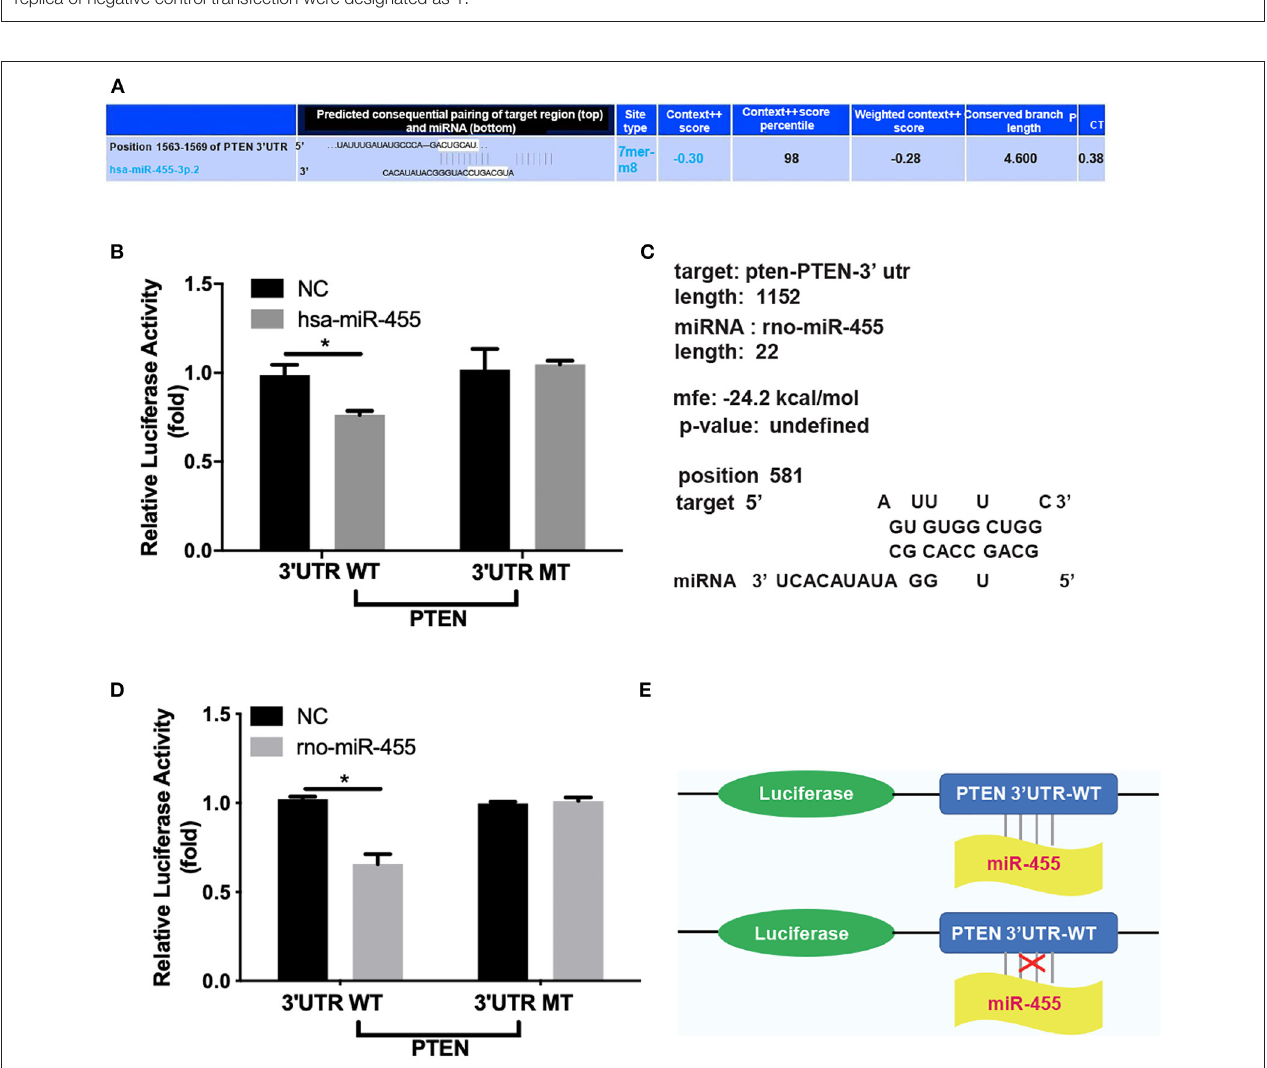
FIGURE 2 | flow cytometry of cell cycle analysis after transfecting hsa-miR-455 mimics, inhibitors or NC (Blue region stands for S phase), and quantification of S phase percentage. (D) Representative images of immunoblotting for PTEN, SMA- α , and OPN expression levels in T/G HA-VSMCs transfected with hsa-miR-455 mimics, inhibitors, or NC, and average band density of three replicates normalized against β -actin. (E) Representative images from fluorescent microscopy for the different groups. * p < 0.05, ** p < 0.01. All experiments were performed with three biological replicates. In all experiments, the values obtained from the first biological replica of negative control transfection were designated as 1.